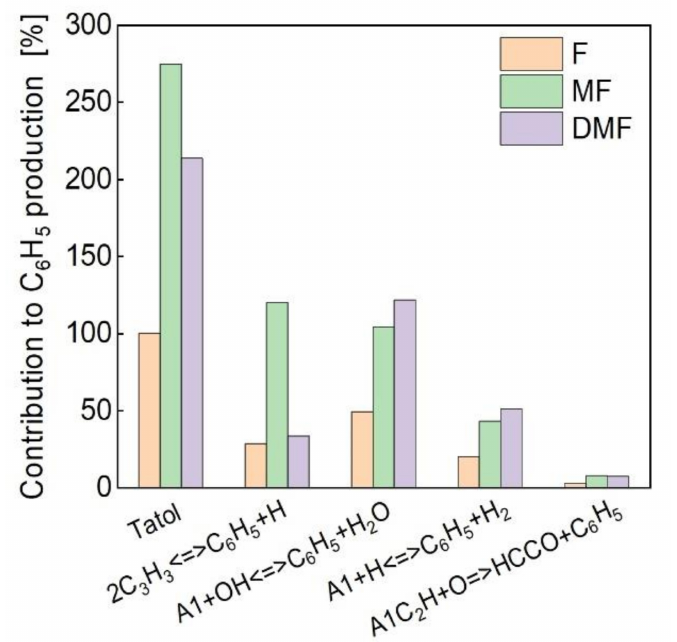
Figure 11. Percentage contribution from each reaction to C 6 H 5 production for the furan, MF, and DMF